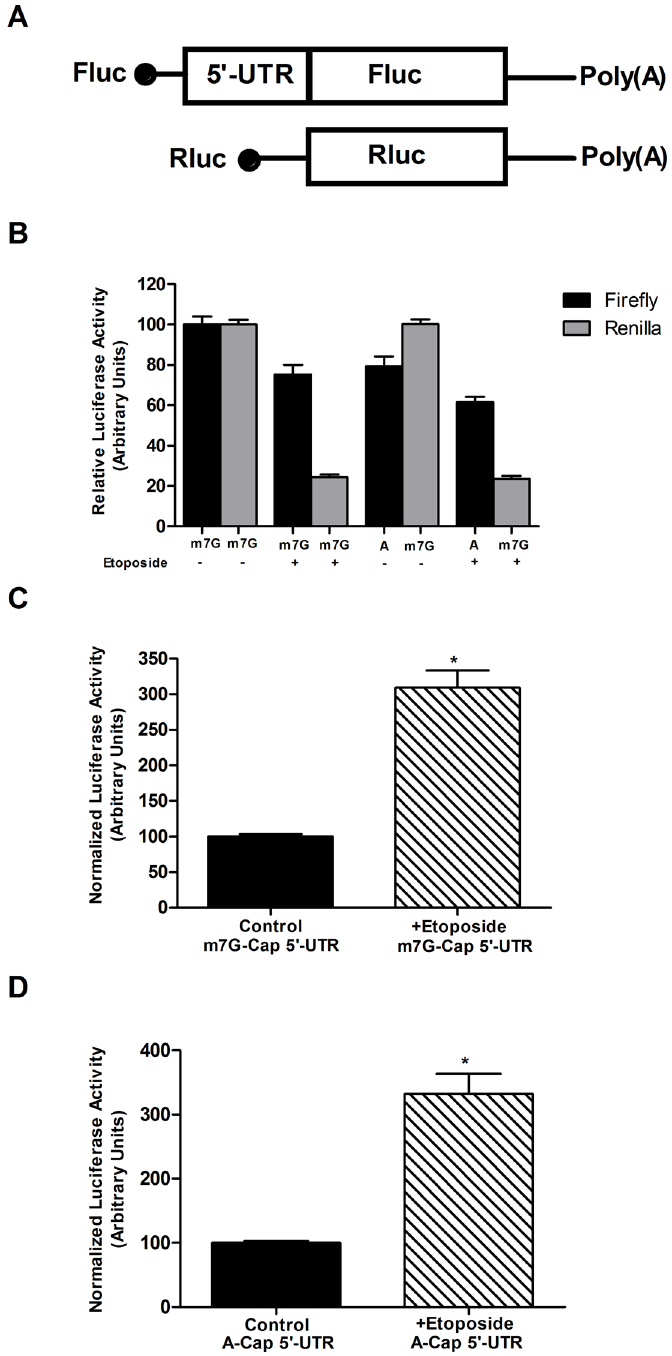
Fig 2. Translation of utrophin-A 5'-UTR with reporter in presence of etoposide. (A) Schematic presentation of monocistronic mRNAs used in the assay. Fluc: Firefly luciferase, Rluc: Renilla luciferase. (B) m7G-capped renilla and either m7G or A-capped firefly with utrophin-A 5'-UTR were co-transfected in etoposide treated and control cells. The individual activities of Fluc and Rluc in each set were presented as mean ± SD (n = 6). The activities of renilla and firefly from m7G-capped transcripts in absence of etoposide were set to 100%. To normalize activities of Fluc constructs containing the utrophin-A 5'-UTRs, the m7G- capped Rluc was used as reference. The results presented in B were used to construct graph in C and D. (C) The normalized Fluc activity driven by m7G-capped Fluc with utrophin-A 5'-UTR transcripts in presence and absence of etoposide as represented in B. Normalized Fluc activity of m7G-capped utrophin-A 5'-UTR